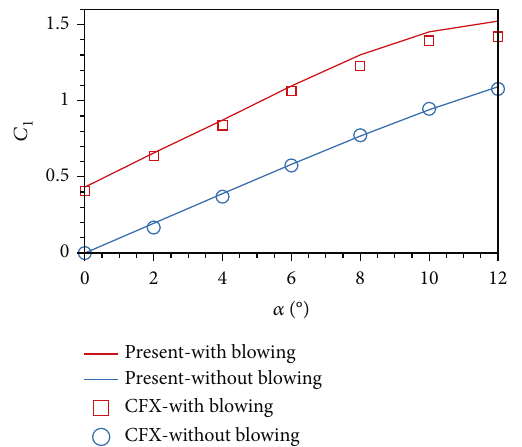
Figure 7: Drag convergence for the RAE2822